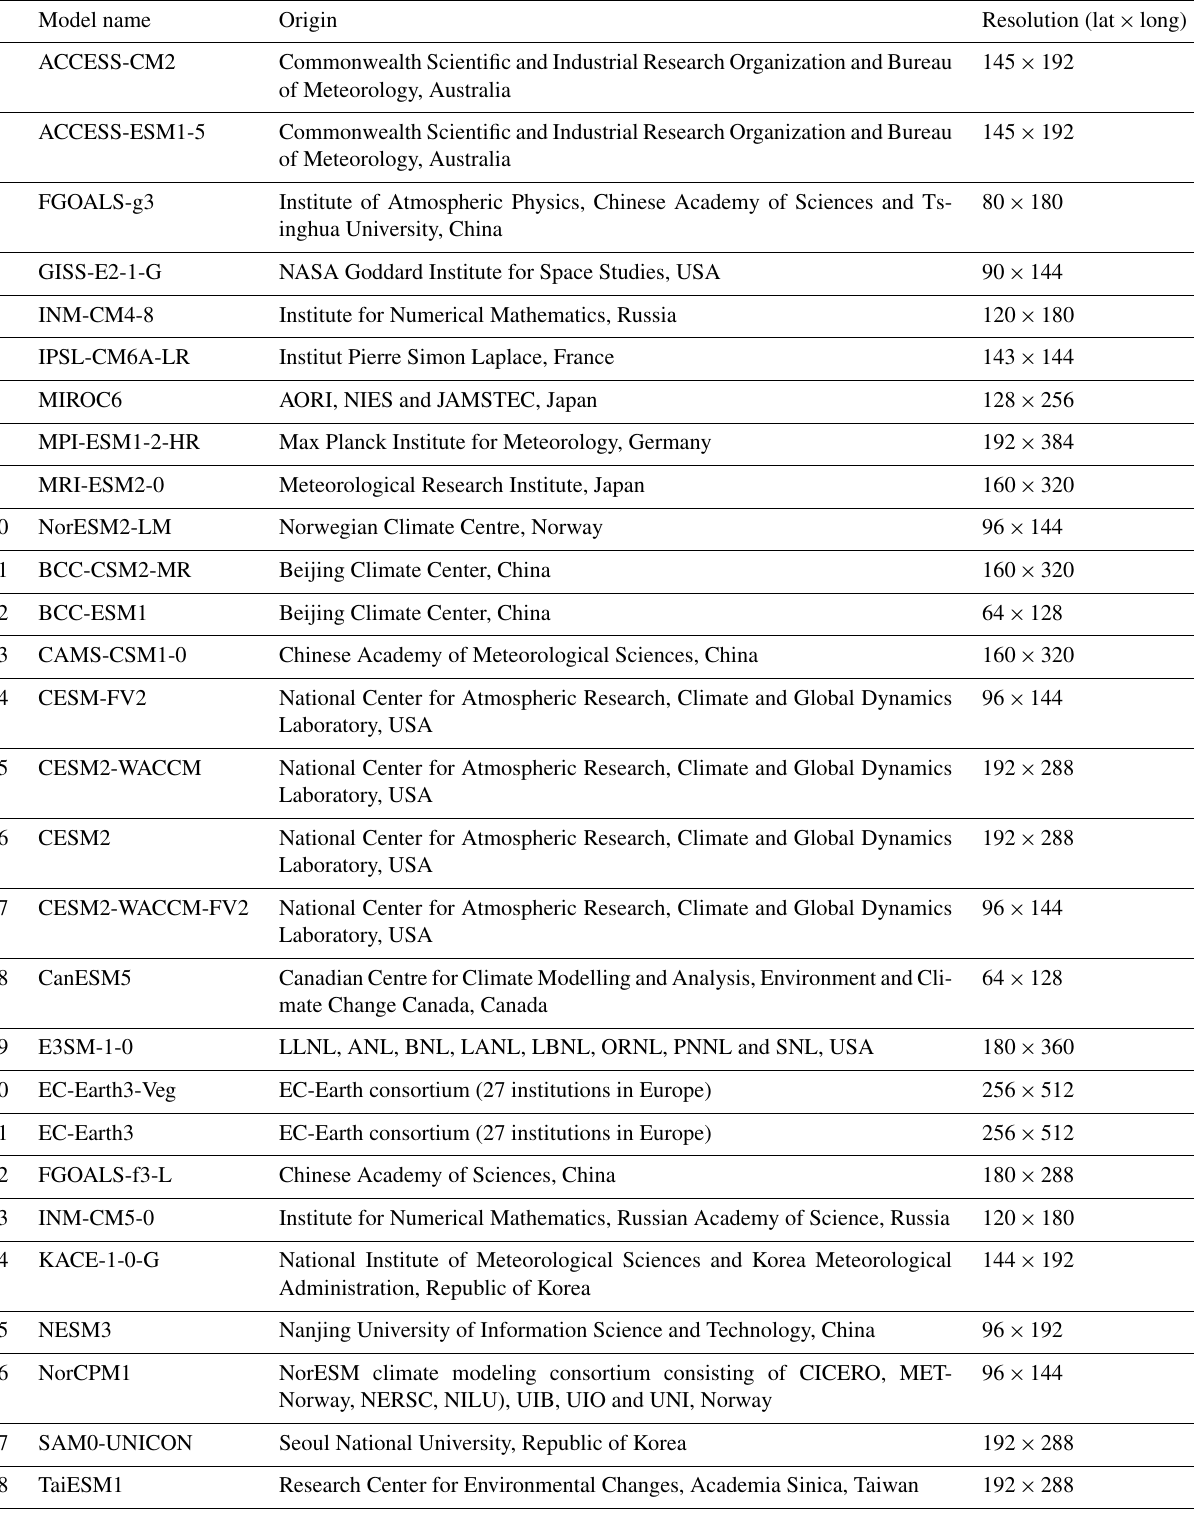
Table 2. The list of CMIP6 models used in the study and their atmospheric horizontal